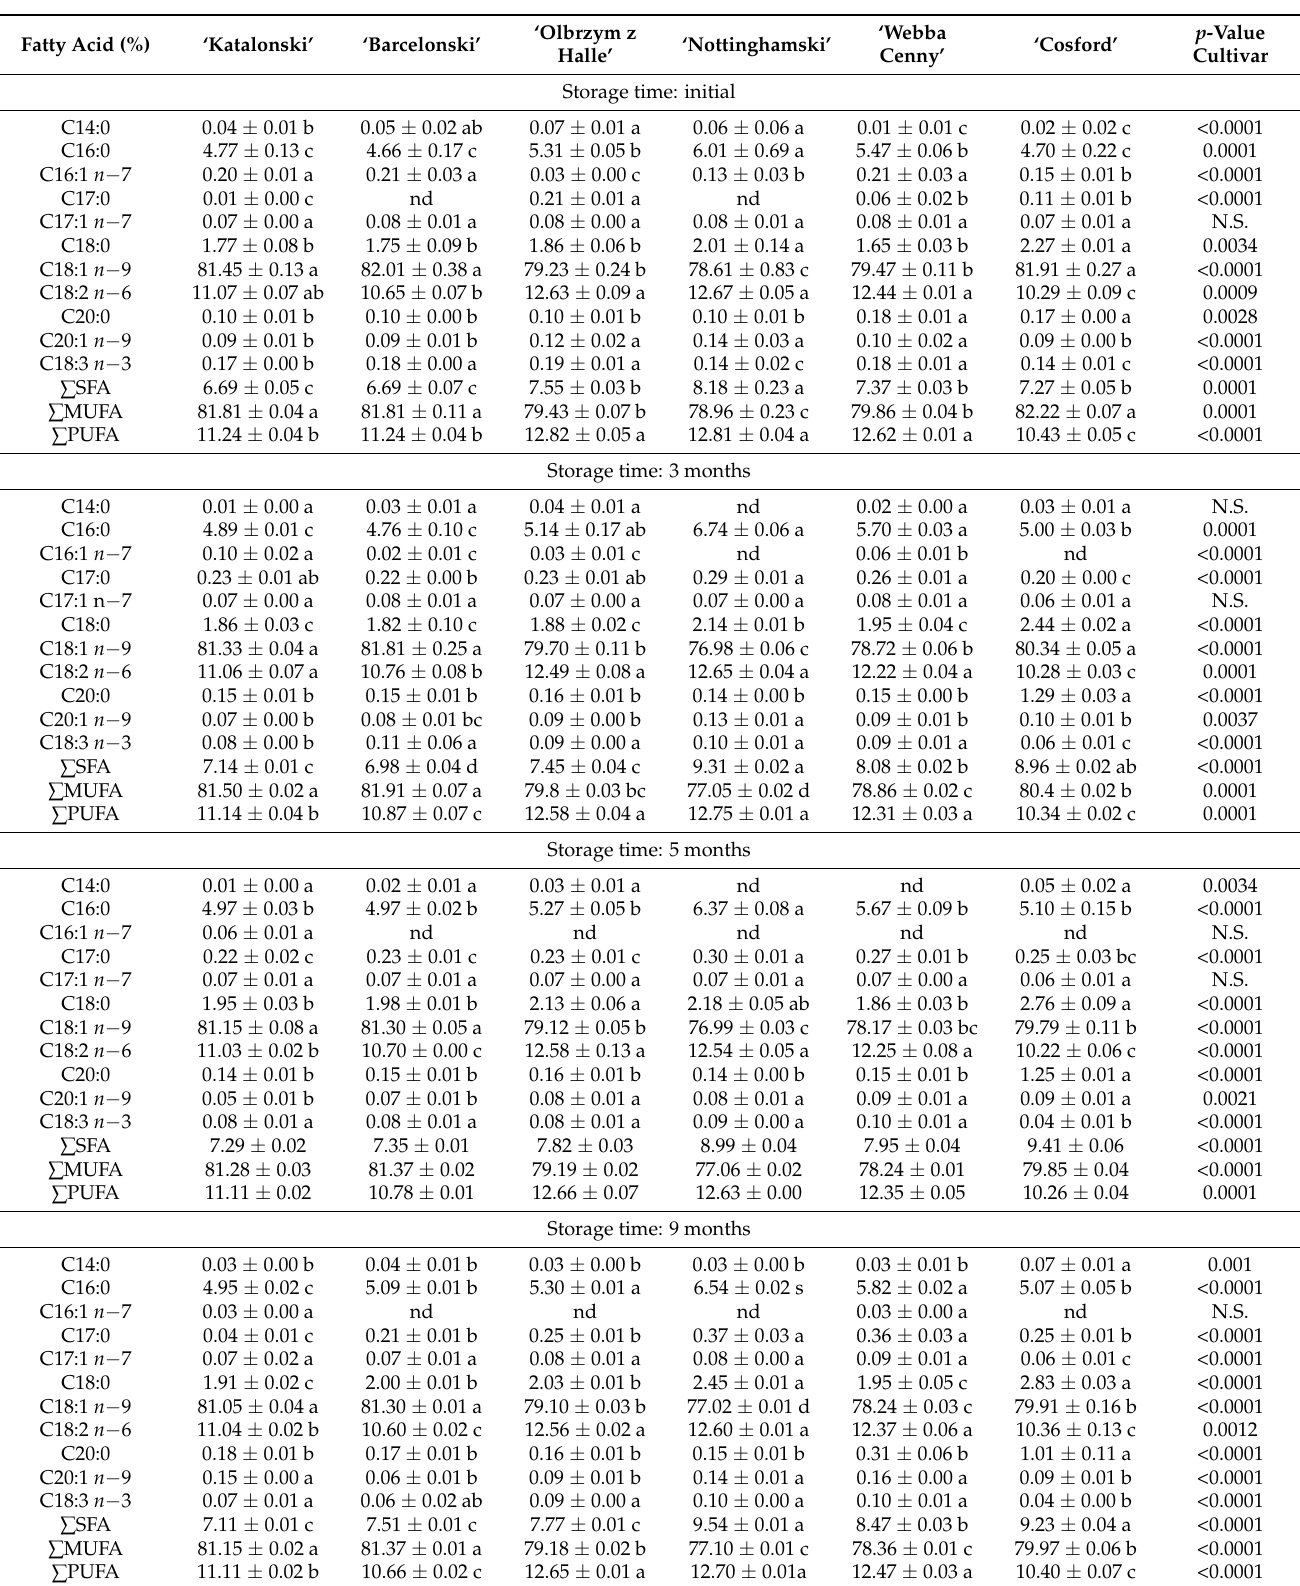
Table 2. Percentage of fatty acids, total SFA, MUFA, PUFA of lipid fractions of oils from six hazelnut cultivars during storage (%, mean value ±